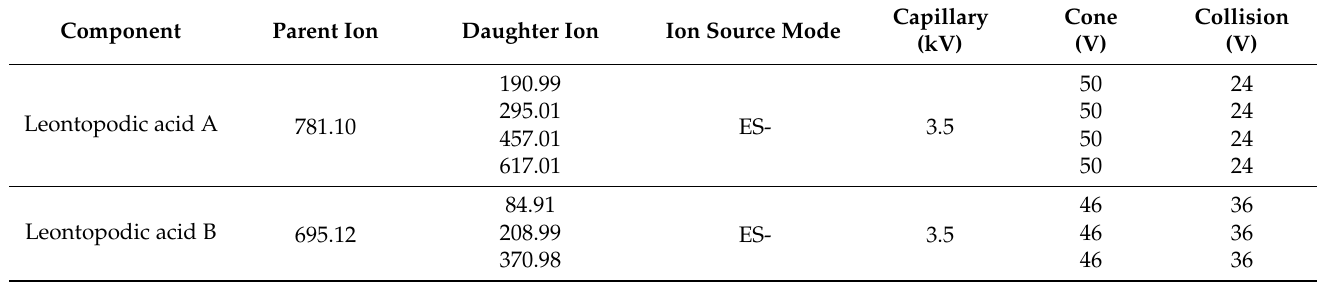
Table 4. Mass spectrum condition.